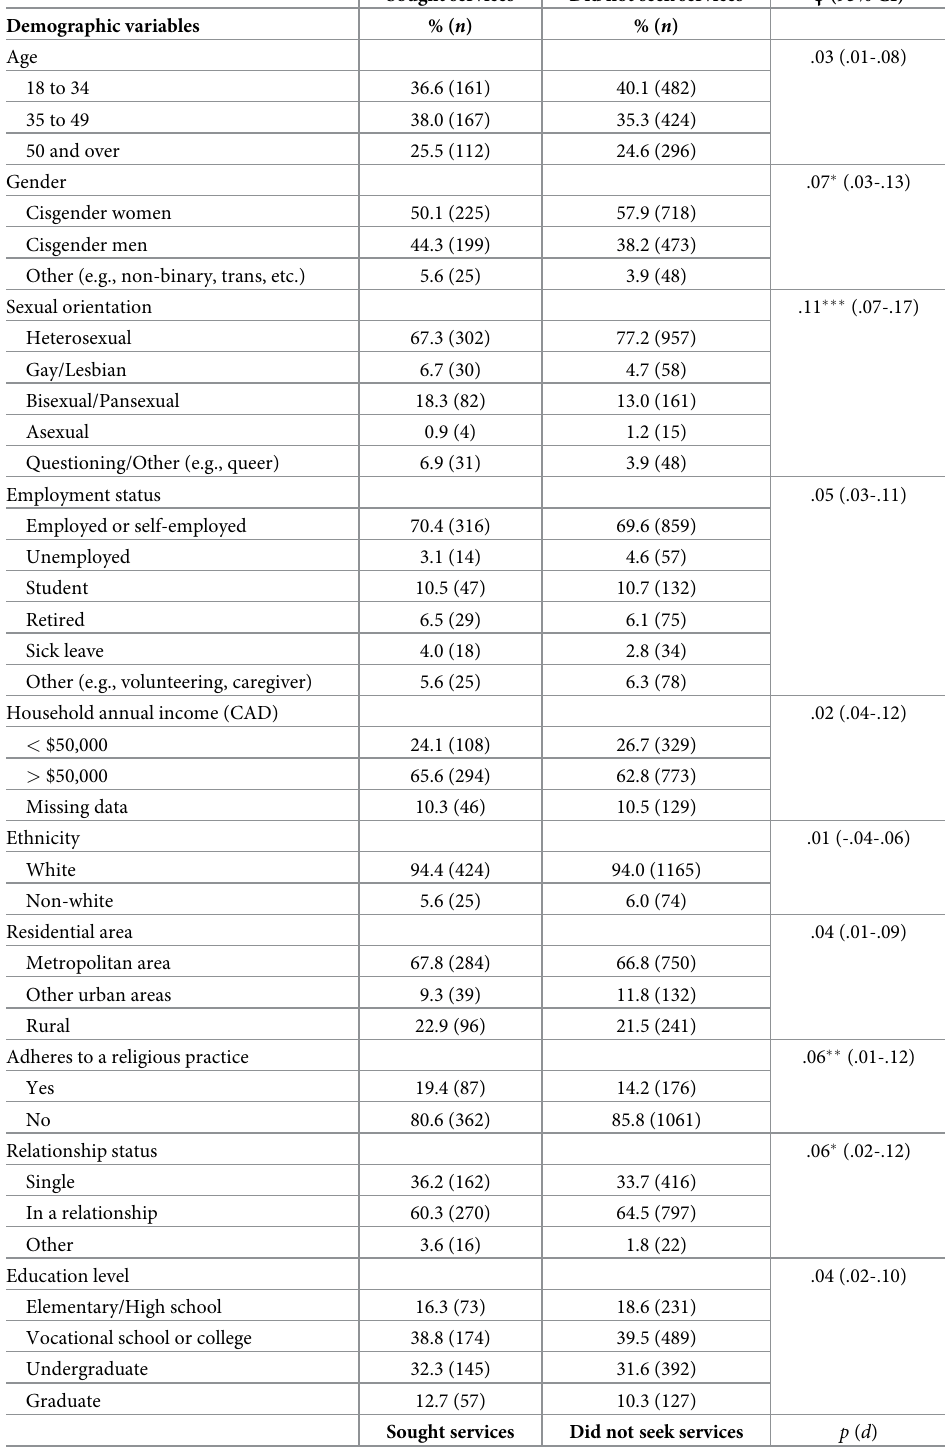
Table 5. Demographic and psychosexual correlates of sexual health service-seeking in the community sample ( n =